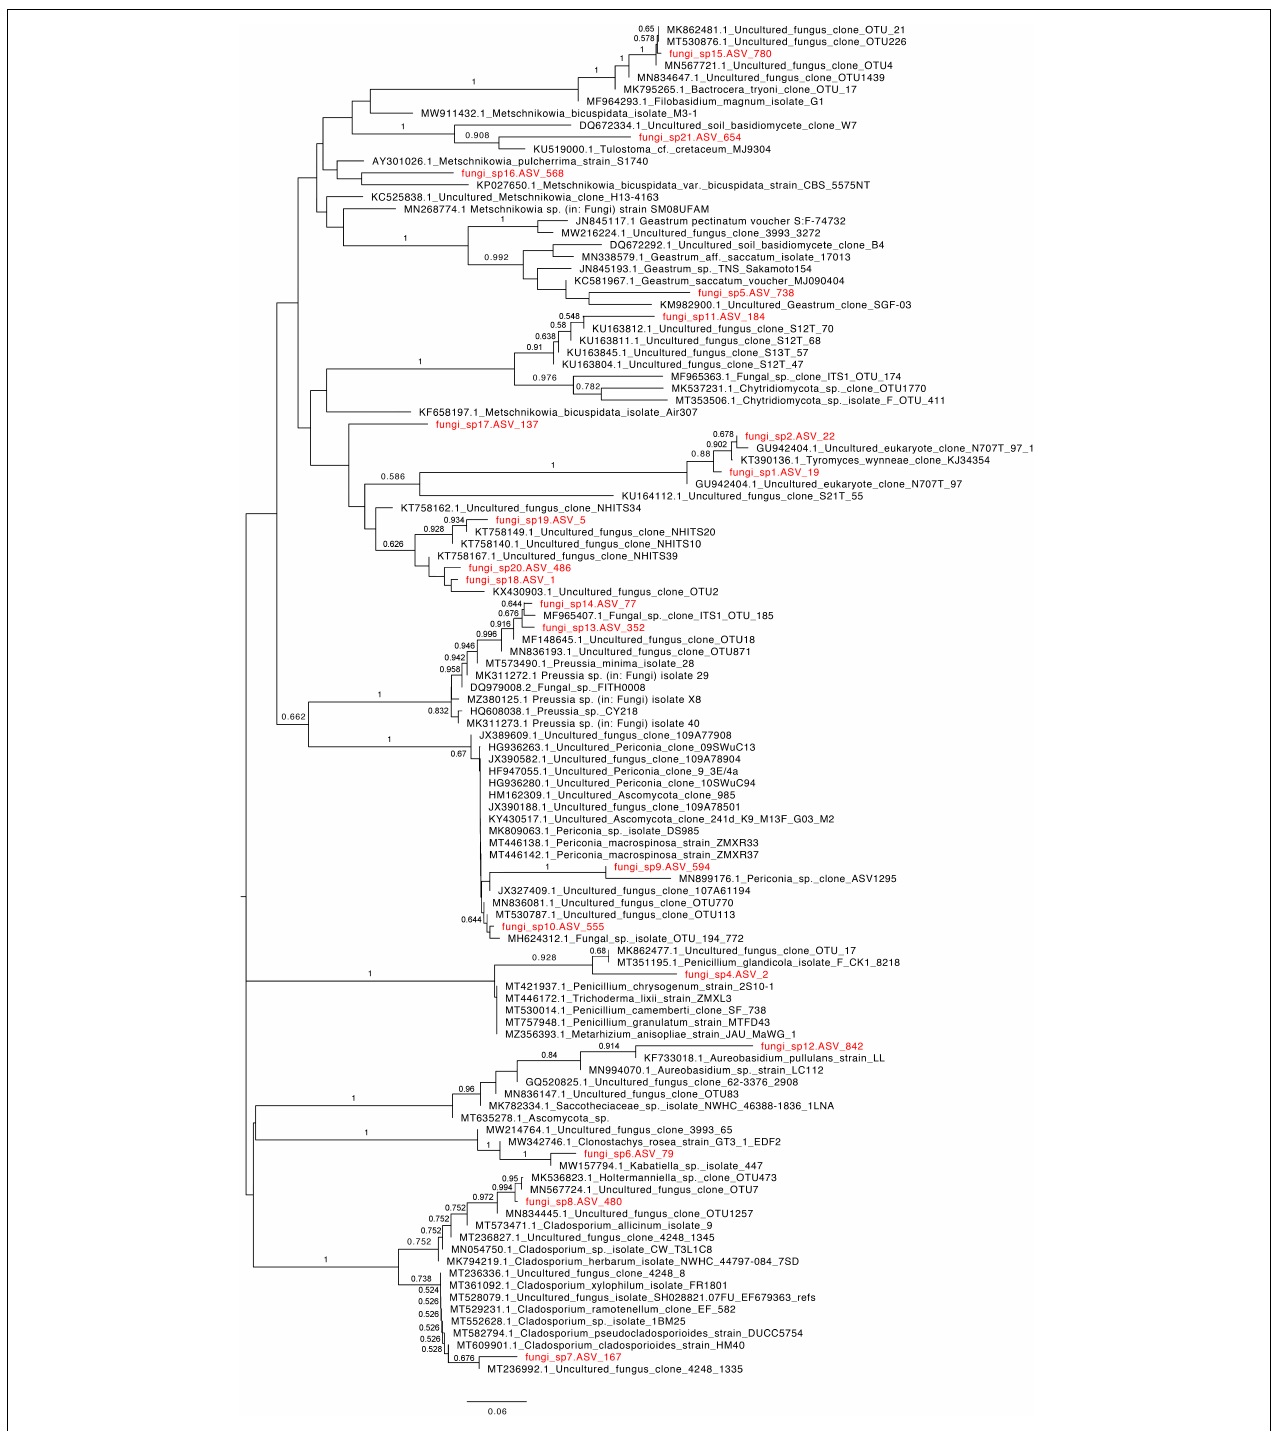
FIGURE 4 | Phylogenetic relationship of deep-sea derived ASVs that were taxonomically assigned at the kingdom level (indicated in red font) with close species based on ITS1 rRNA sequences using the neighbor-joining algorithm. Bootstrap values > 50% are indicated above the branches.